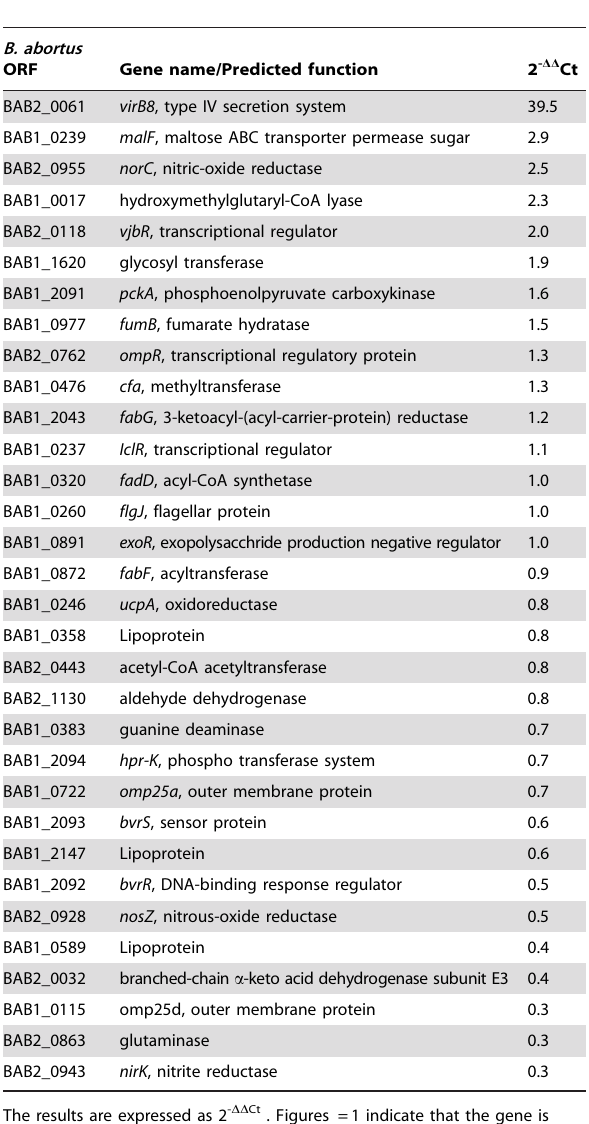
Table 2. Intracellular transcriptional level of B. abortus 2308 genes candidates to be controlled by